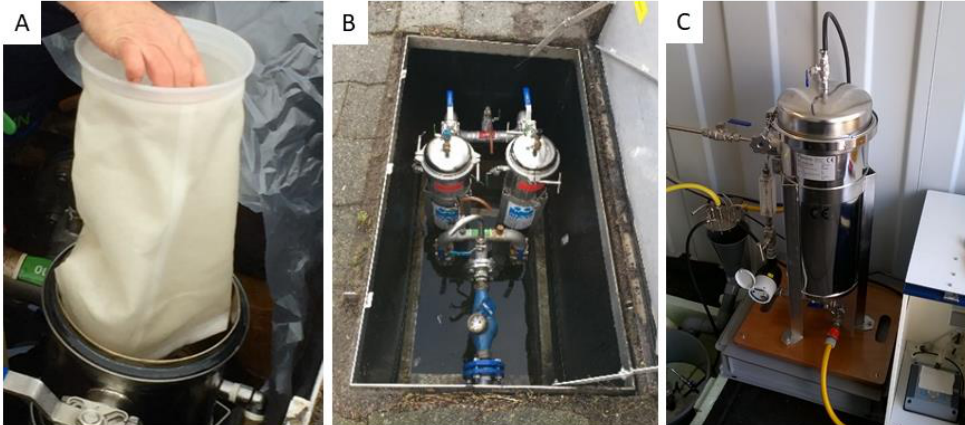
Figure 1. Equipment for the study of particulate material: ( A ) 25 µm filters for particle collection; ( B ) fixed filter holder system built into the distribution system for the temporal study; and ( C ) mobile filter holders for the spatial study.